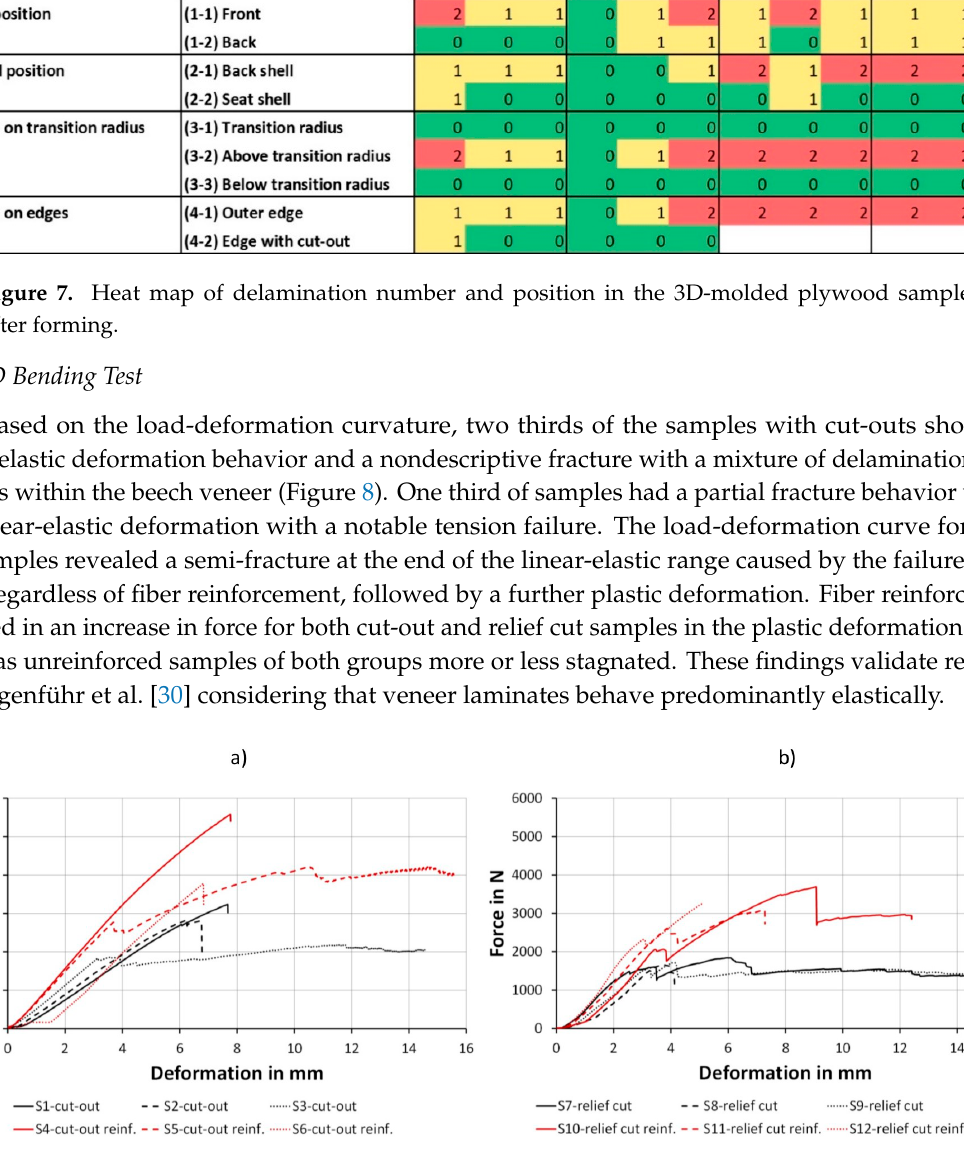
Figure 8. Force-path diagram for specimens with cut-out ( a ) and relief cut ( b ).